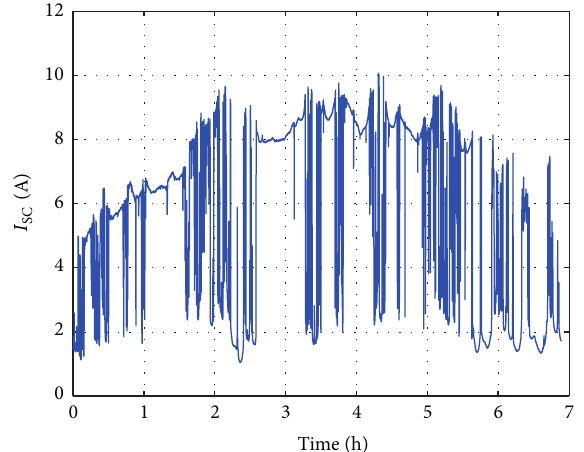
Figure 4: Measured 𝐼 of a single PV module on July 1st, 2010, with SC a sampling frequency of 25 Hz.